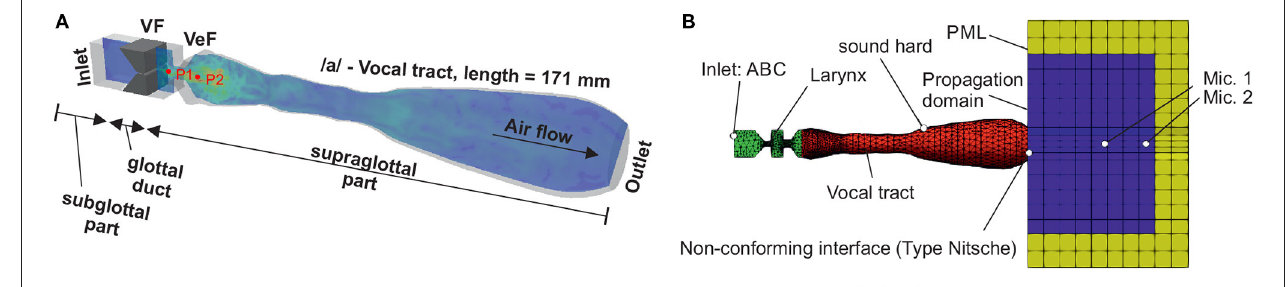
FIGURE 2 | (A) 3D representation of simVoice , including a velocity field in the mid-coronal plane, the vocal folds (VF), the ventricular folds (VeF), and the vowel /a/-vocal tract. Points P1, and P2 are located 6mm, and 20mm in distance to the vocal folds. (B) Geometry and domain of the CAA model of simVoice as introduced by Schoder et al. (2020). Mic.1 and Mic.2 are located 5 and 8cm in distance of the vocal tract exit